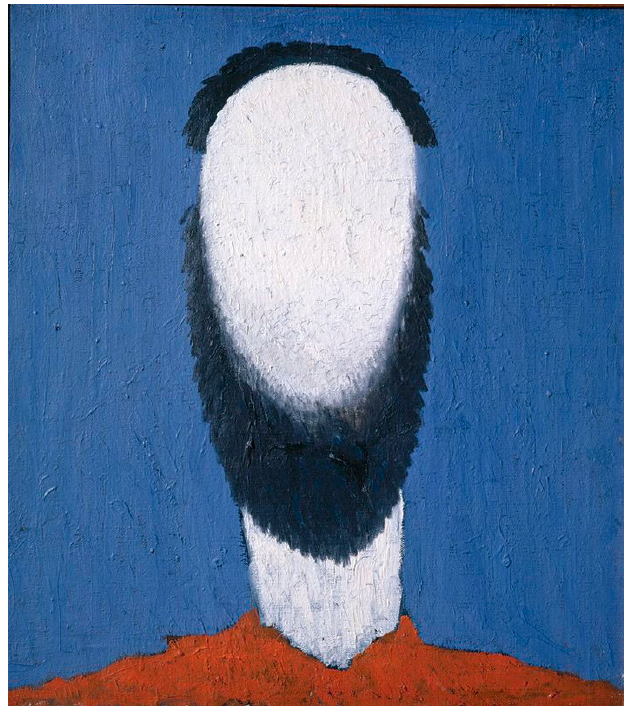
Figure 5. Kazimir Malevich. Head of a peasant.